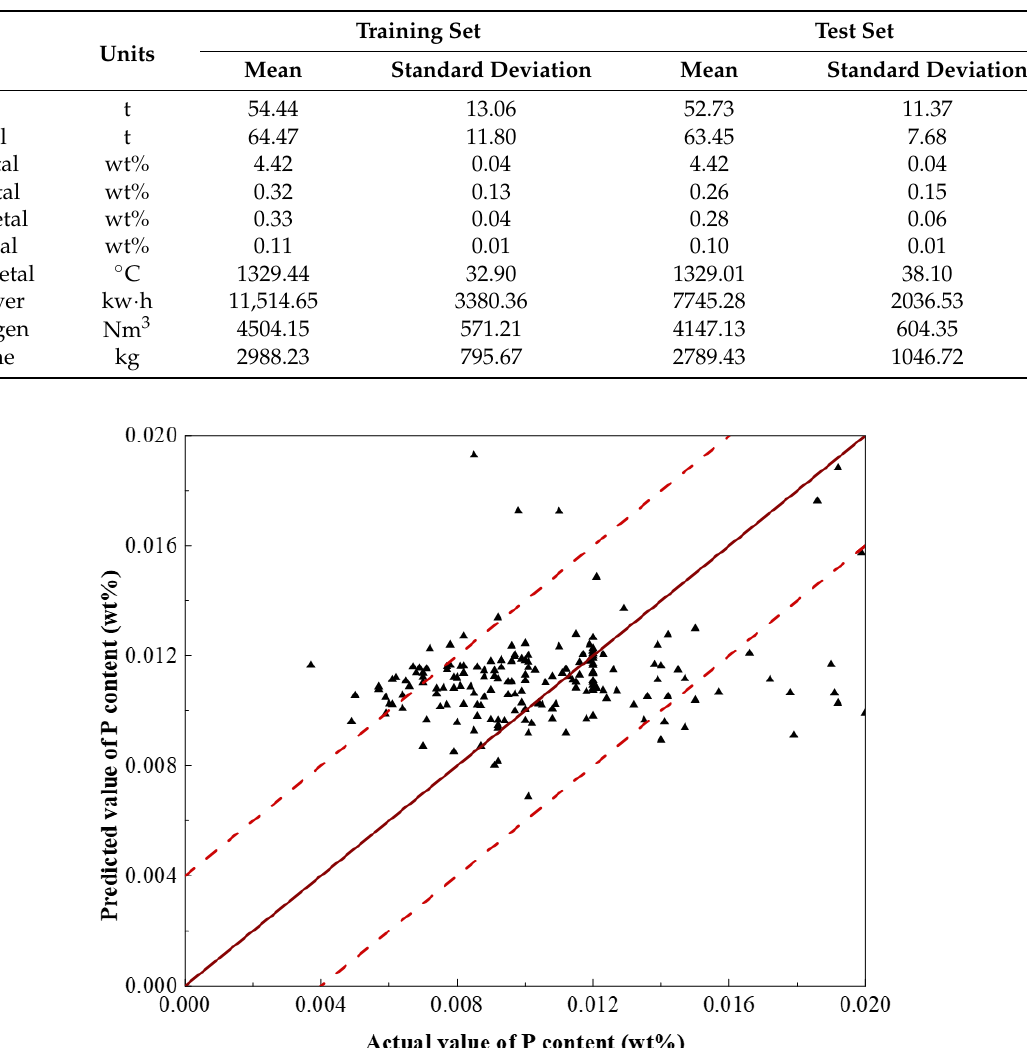
Table 3. Mean and standard deviation of input and output data.